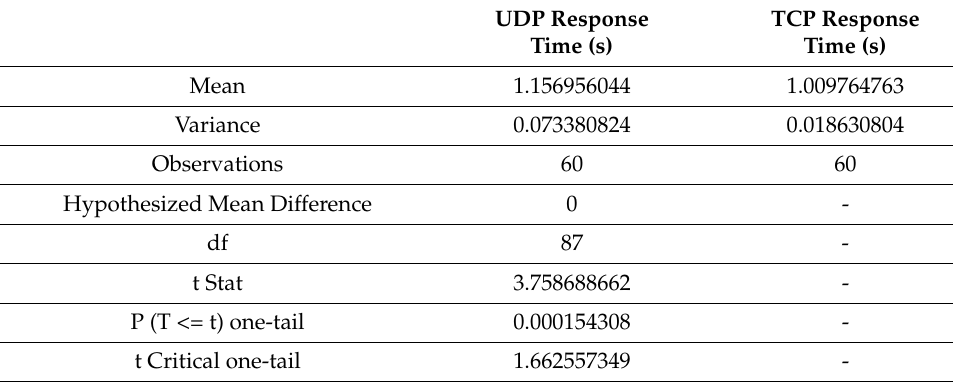
Table 9. Results, Experiment